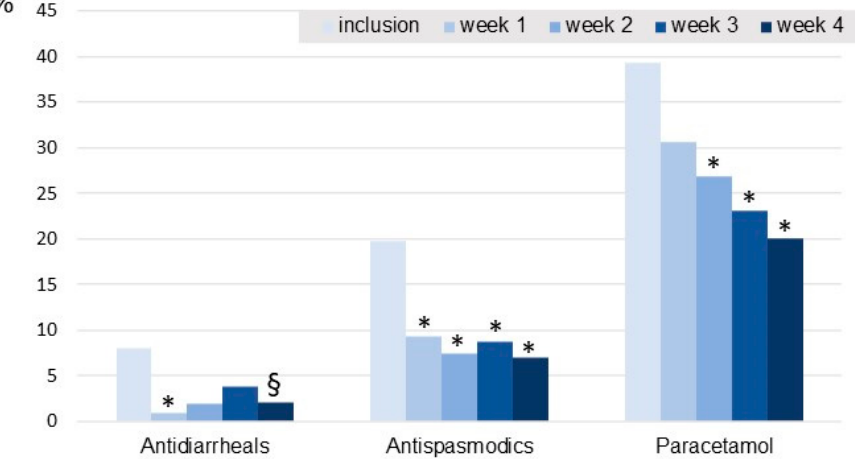
Figure 5. Changes in concomitant treatment intake from inclusion to the end of the 4-week sup- plementation period expressed as the percentage of patients treated at each time point. * p < 0.05 compare to the percentage treated at inclusion; § p = 0.0588.